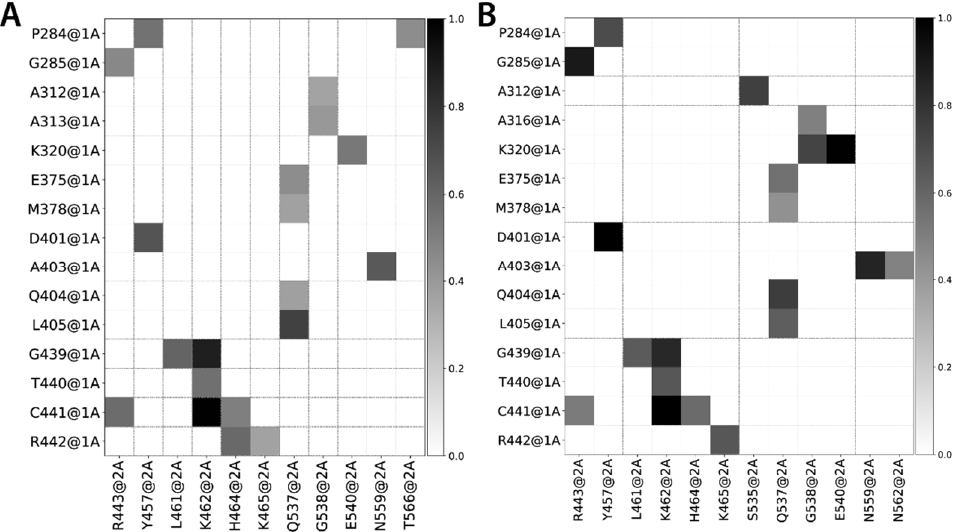
Figure 7. Plot of the interface contact matrix between Domains 1A and 2A in RNA-free ( A ) and RNA-engaged ( B ) NSP13. Contacts are colored from white to black if they were observed in 0% or 100% of the simulation time, respectively.